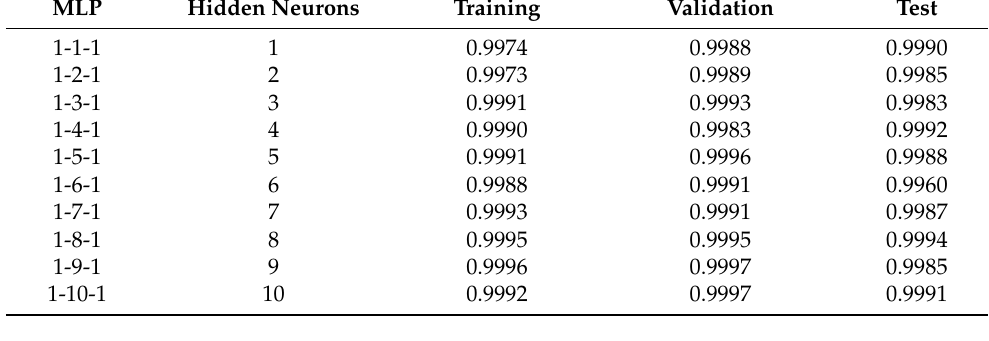
Table 4. R values of artificial neural networks.